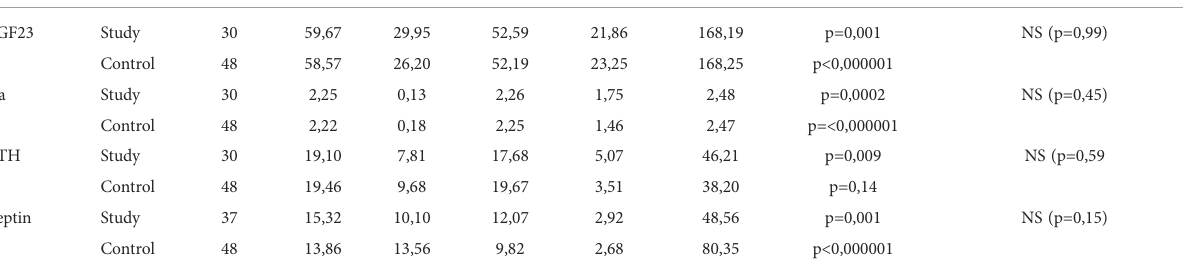
TABLE 4 Ca, PTH, FGF23, leptin values in the study and control group.